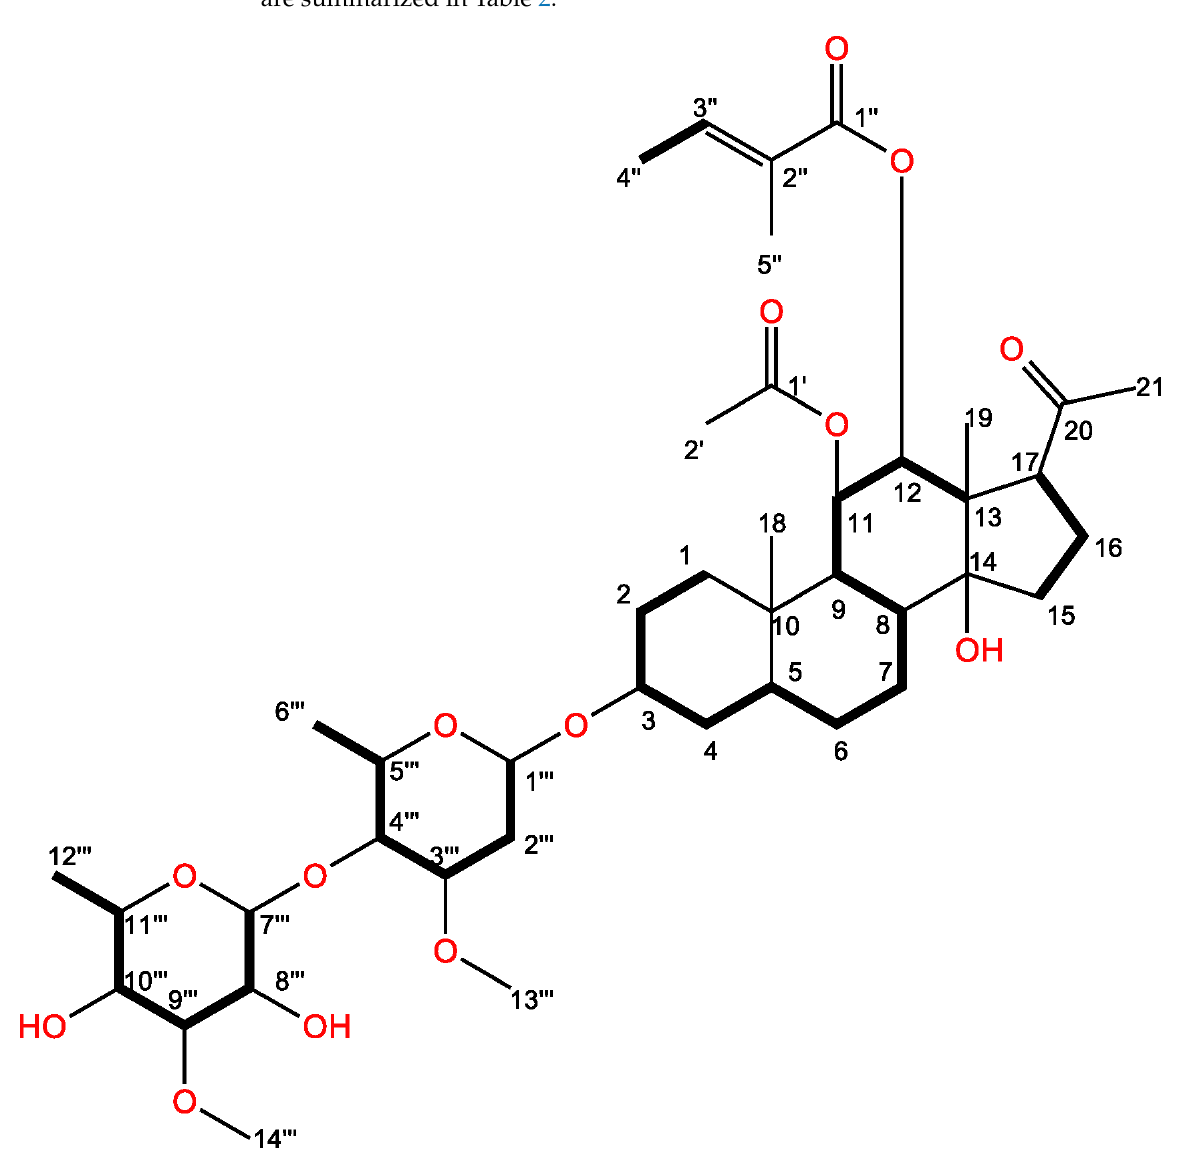
The molecular structure of the characterized active compound was determined as C 42 H 66 O 14 by using HR-ESIMS m/z 817.4355 [M + Na] + (calcd for C 42 H 66 O 14 Na 817.4350) (Figure 4). The specific rotation of the compound showed [ α ] D23 = +31 (c 0.21, CH 3 OH); IR (neat) 3446, 2972, 2931, 2864, 1740, 1716, 1700, 1373, 1256 cm − 1 . The 1 H and 13 C-NMR data